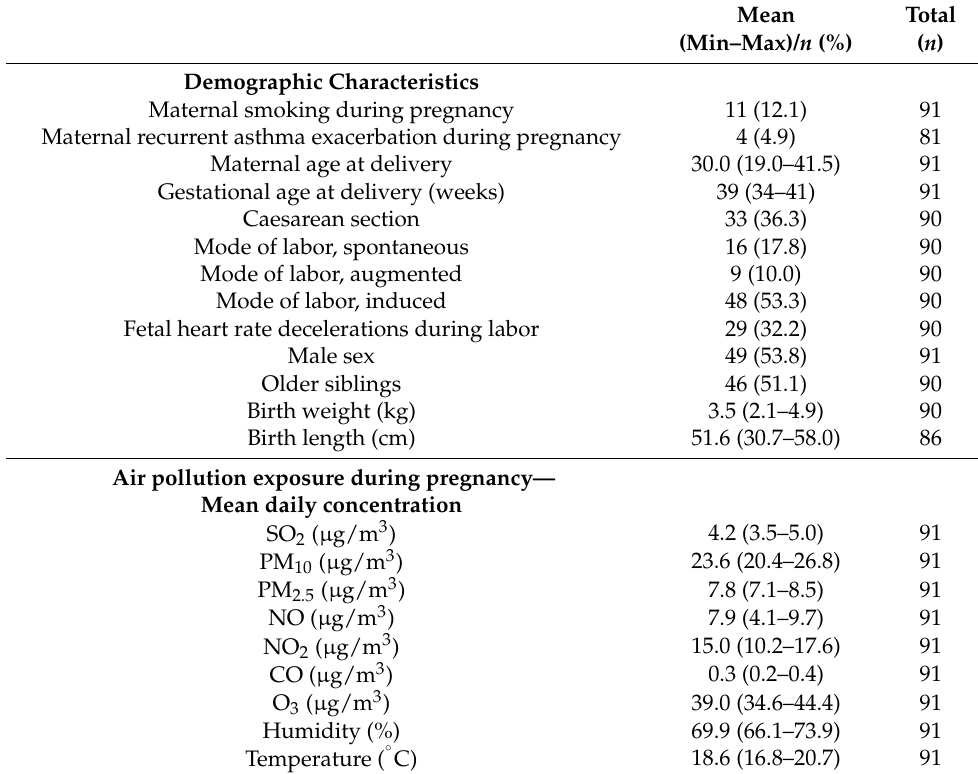
Table 1. Population